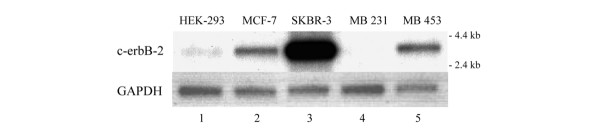
Expression of the c-erbB-2 gene in various cell lines. Total RNAs from HEK-293 and human breast cancer cell lines MCF-7, SK-BR-3, MDA-MB-231 and MDA-MB-453 were probed with c-erbB-2 cDNA and thereafter with glyceraldehyde 3-phosphate-dehydrogenase (GAPDH) cDNA as a control.